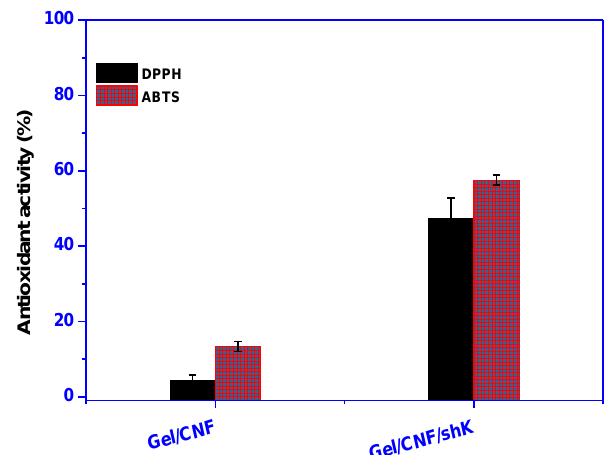
Figure 7. Antioxidant activity of the film.